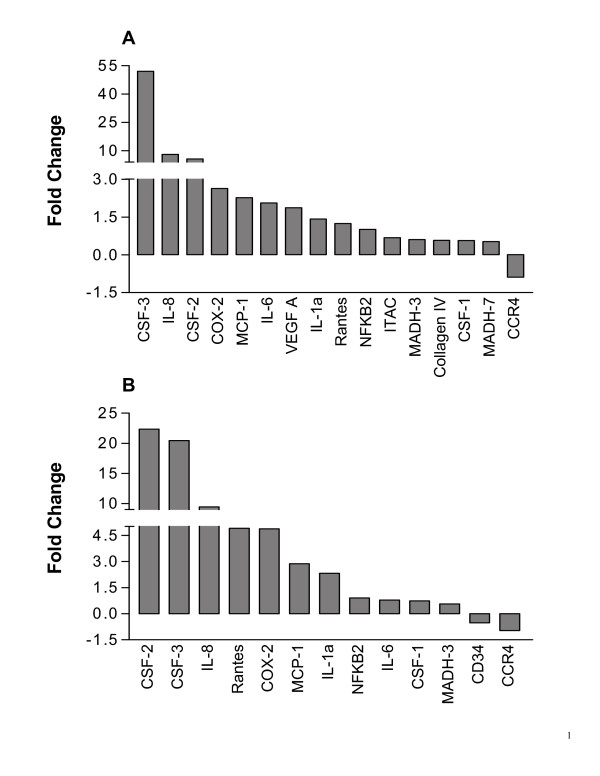
Quantification of changes in gene expression in thrombin treated human aortic endothelial cells determined using the LDA based QRT-PCR. Each bar represents the fold change from control (n = 3; based on geometric mean data) at 2 hours (A) and 12 hours (B) post-thrombin. Targets that were altered by less than 50 % from the control were excluded from this figure.